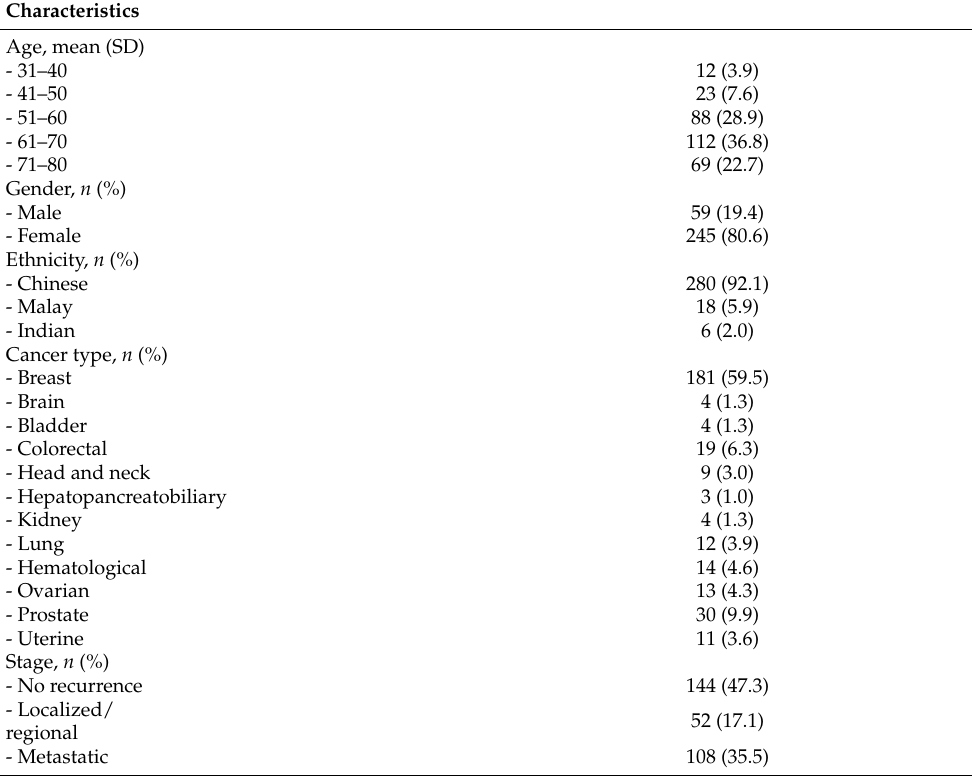
Table 1. Demographic and clinical characteristics of the study participants ( N =